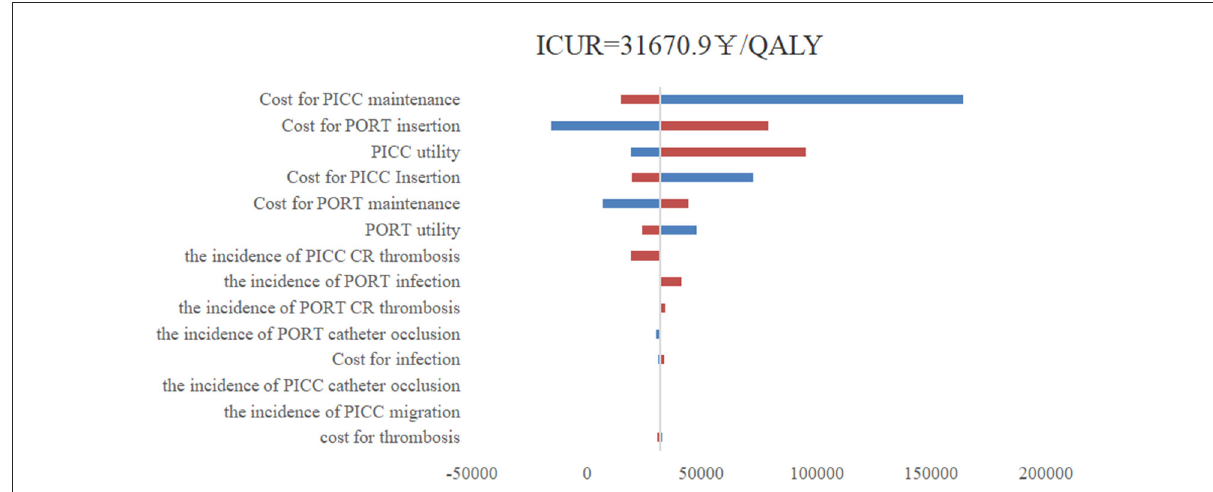
FIGURE2 Probabilistic sensitivity analysis; QALY, quality-adjusted life-year.